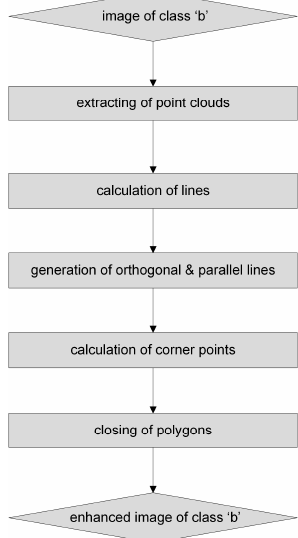
Figure 2. Steps in the cartographic enhancement (Level 2) at the example of class “building”.